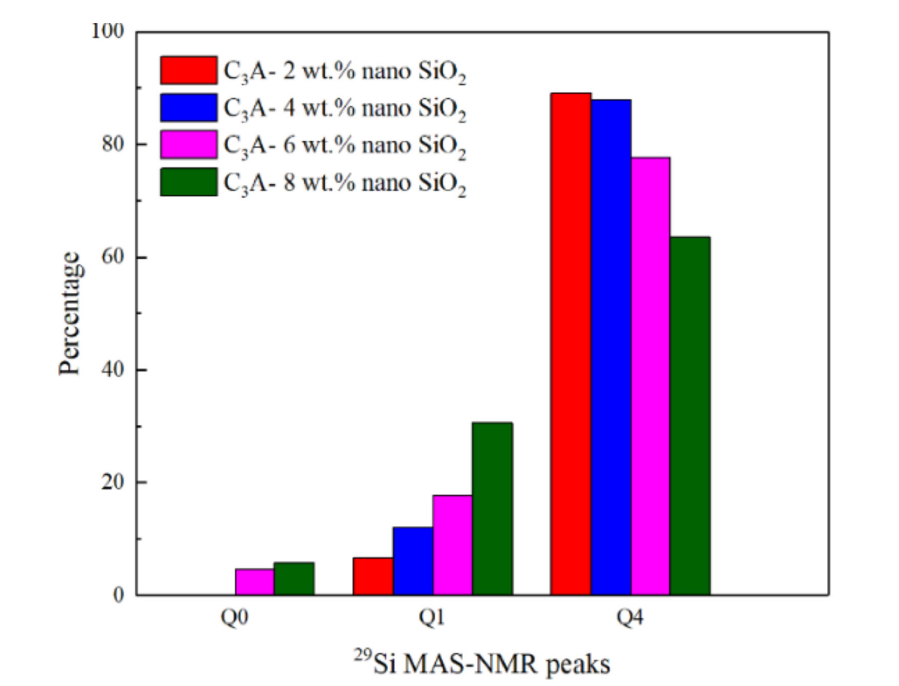
Figure 7. Percentages of different Q n peaks, calculated by Gaussian deconvolution from the 29 Si MAS-NMR